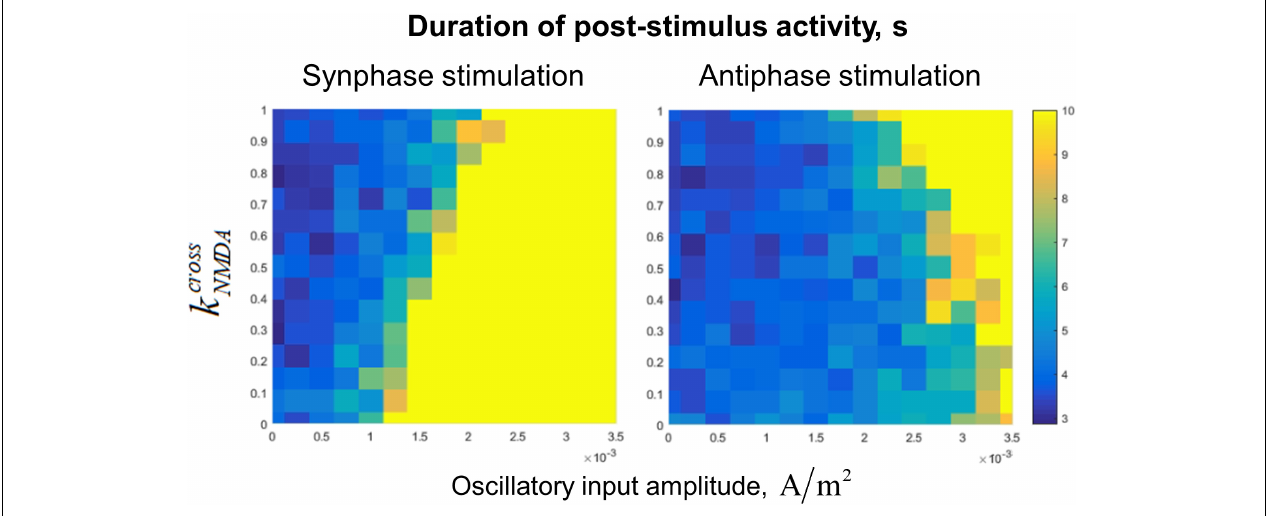
FIGURE 5 | Dependence of post-stimulus activity duration of the two-circuit system on the amplitude of input sinusoidal oscillations and the NMDA-to-total inter-circuit current ratio ( k cross NMDA ). Left panel: the oscillations are delivered to the circuits in the same phase, right panel: oscillations are delivered in the antiphase. Oscillation frequency: 40 Hz, noise amplitude: 0.014 µ A/cm 2 . Note that increasing of k cross NMDA reduces the stabilizing effect of the in-phase input, but increases the effect of the anti-phase